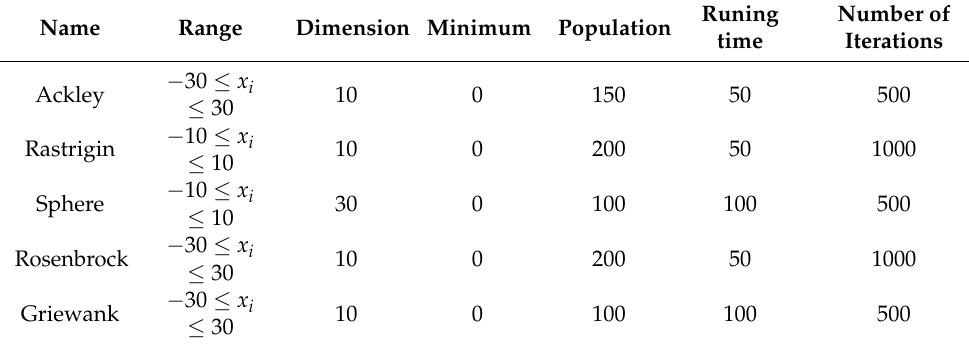
Table 1. Description of test functions and settings of simulation